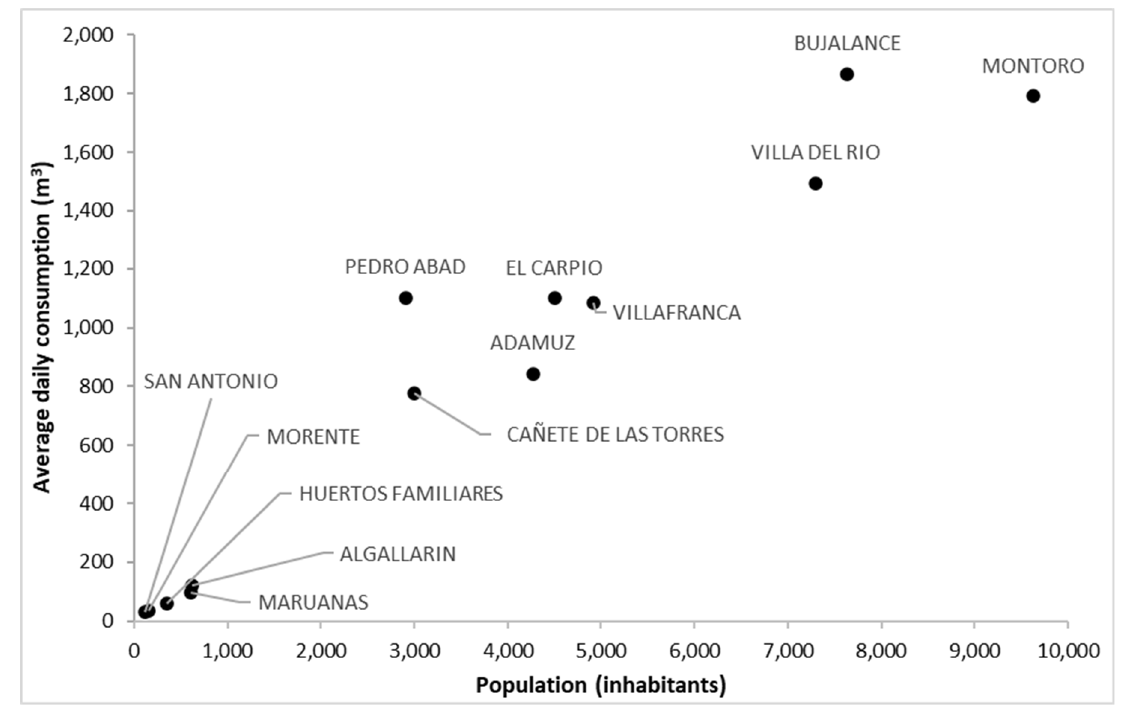
Figure 3. Population vs. average daily consumption.